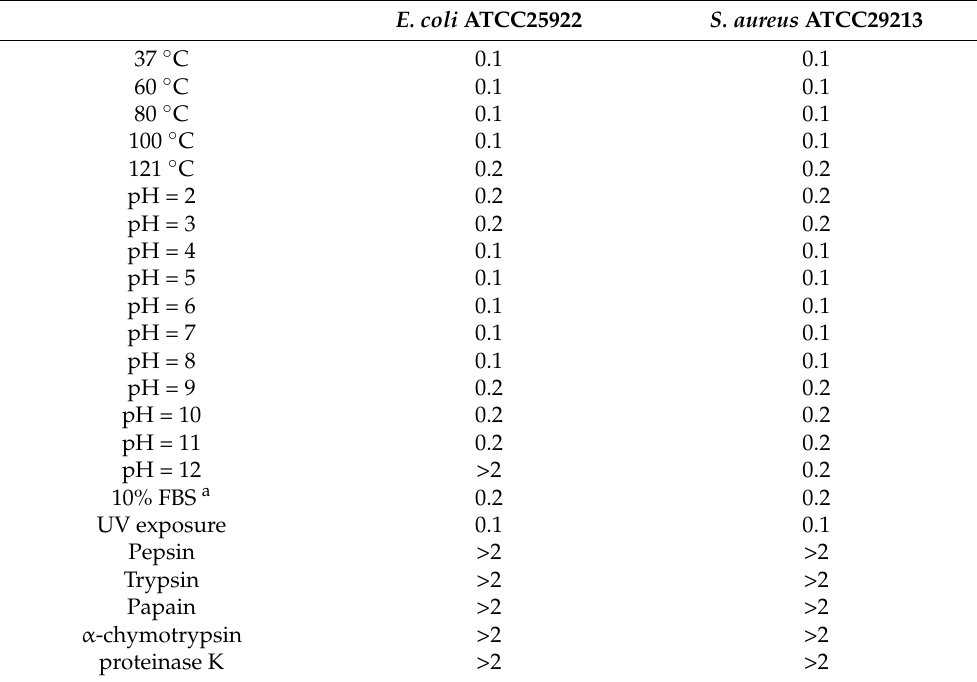
Table 3. Effects of temperature, extreme pH, serum, and protease on antimicrobial activity of Z- d14CFR (MIC,